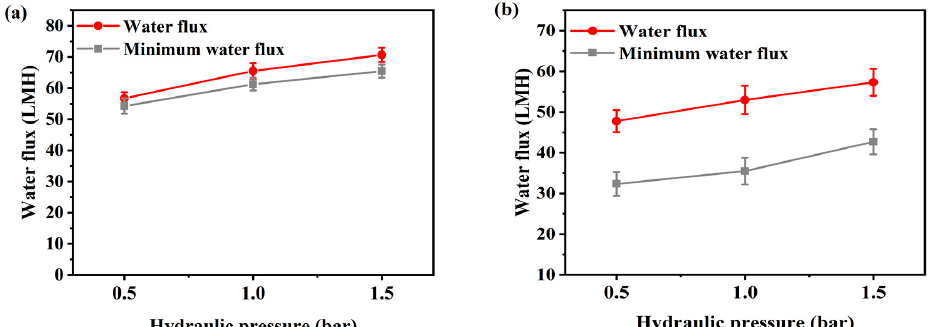
Figure 3. ( a ) Average water flux and minimum water flux of AL-FS mode and ( b ) average water flux and minimum water flux of AL-DS mode tested with hydraulic pressure (PAFO). Feed solution: spent dialysate (1 L); Draw solution: concentrated dialysis solution (1 L); Operating time: 1 h; Pressure: 0.5–1.5 bar; System temperature: 36.5 ± 0.5 ◦ C. The experimental flow rate condition is fixed at 500 mL / Table 2. Comparison of the performance of different methods for reuse of spent dialysate. Membrane